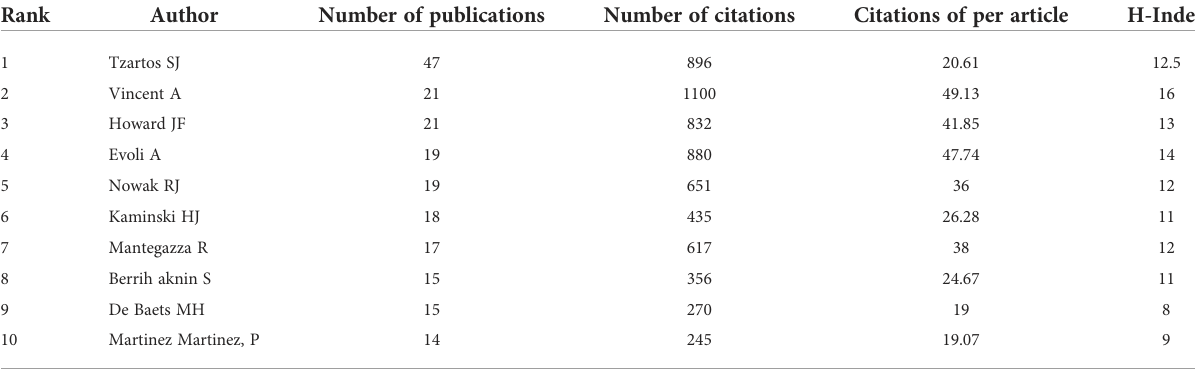
TABLE 5 The top 10 most productive authors contributed to targeted immunotherapy for